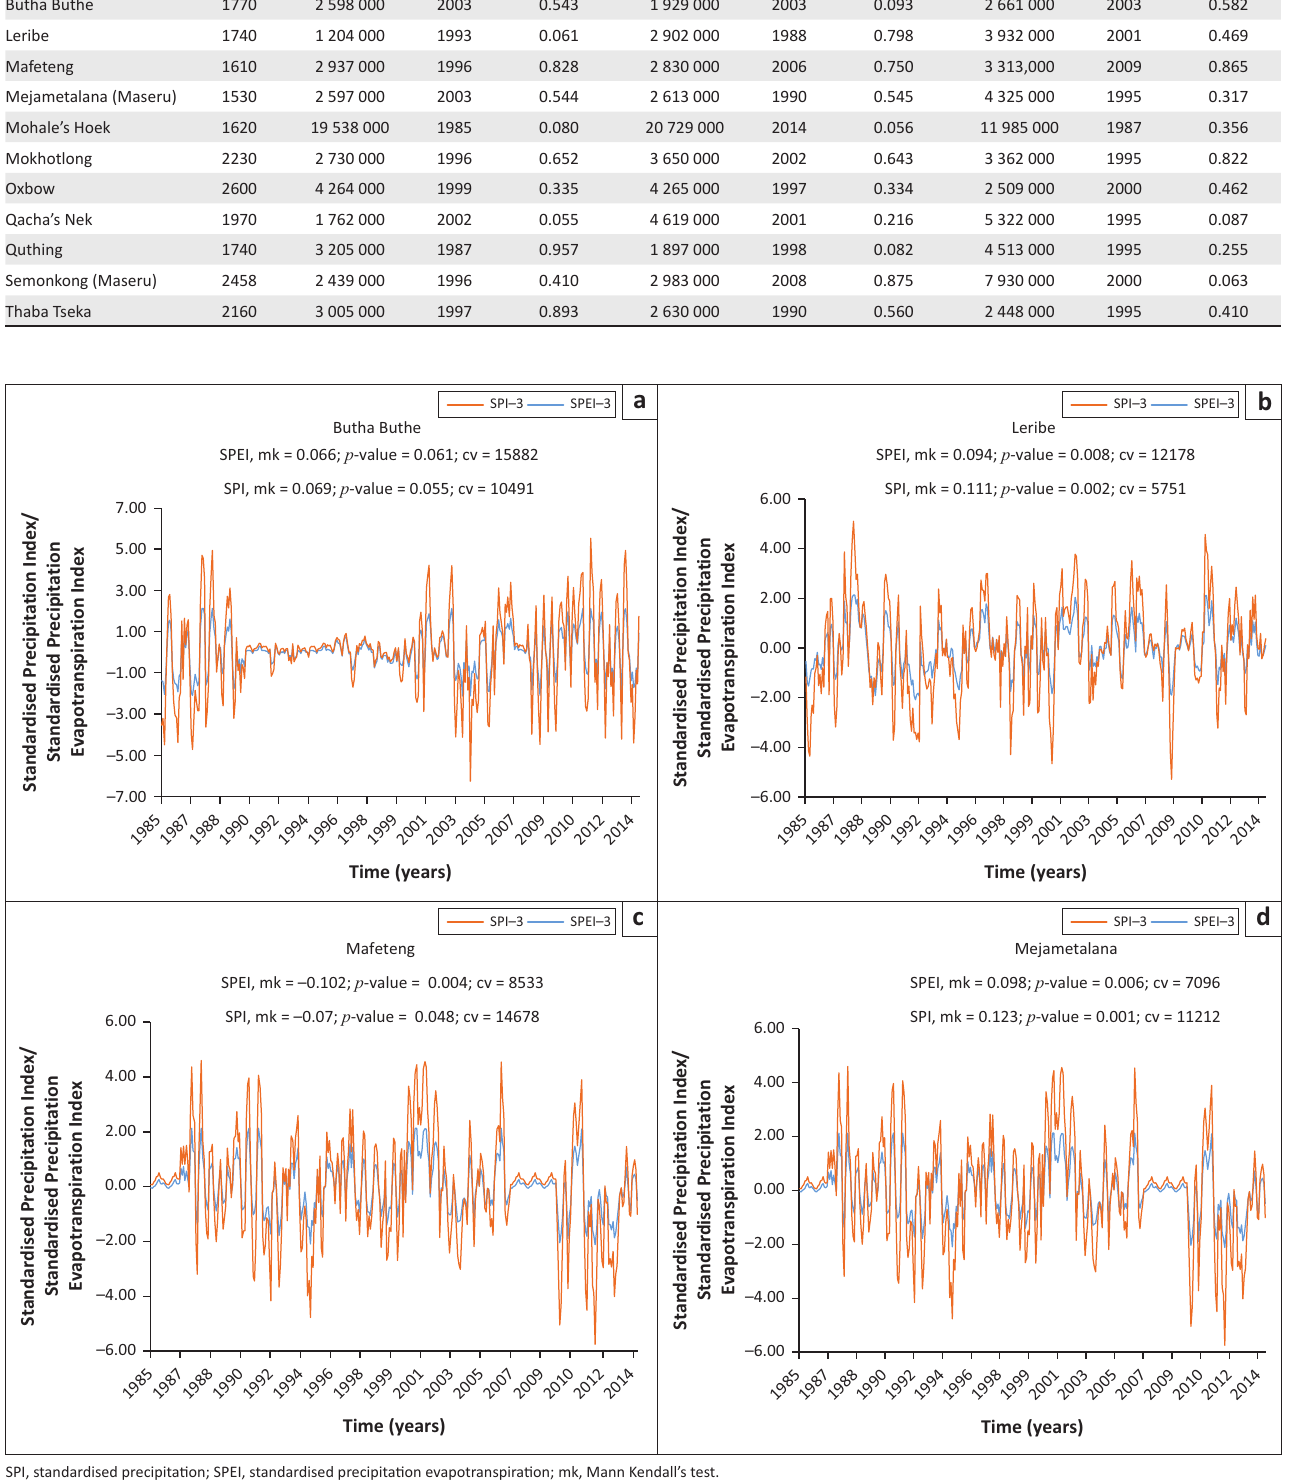
FIGURE 2: Standardised precipitation/standardised precipitation evapotranspiration-3 plot. FIGURE 2 continues on the next page